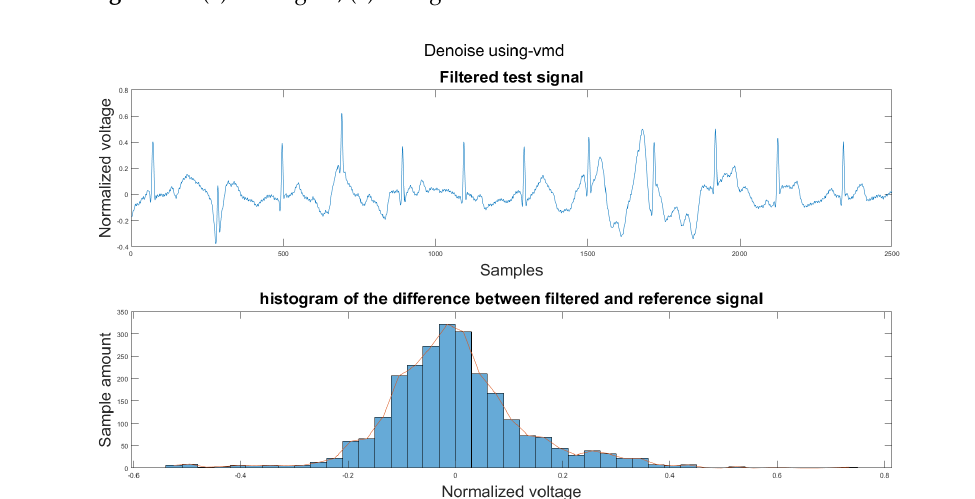
Figure A5. (1) Test signal, (2) histogram of the